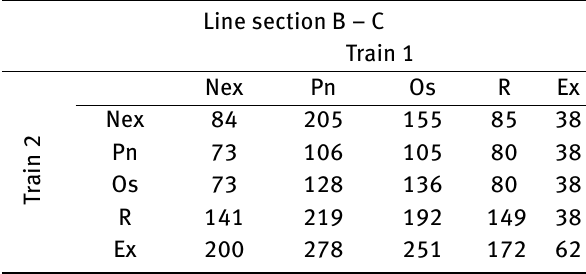
Table 3: Results of the headway calculator after maximization Line section B –